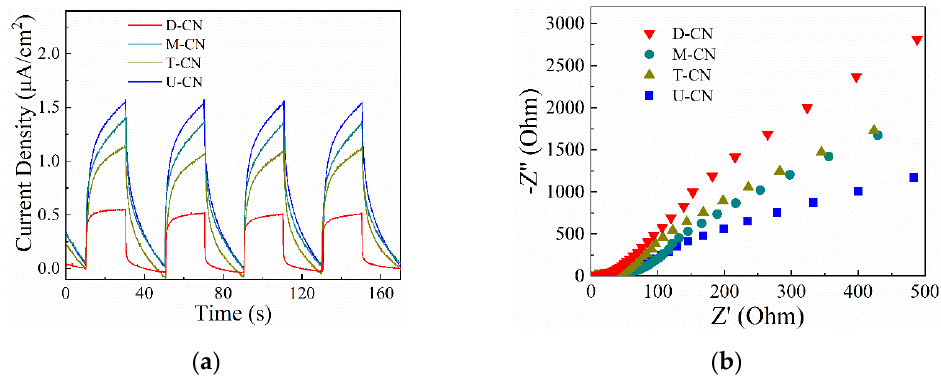
Figure 8. ( a ) Photocurrent response; ( b ) EIS Nyquist plots of D － CN, M － CN, T － CN, U － CN.